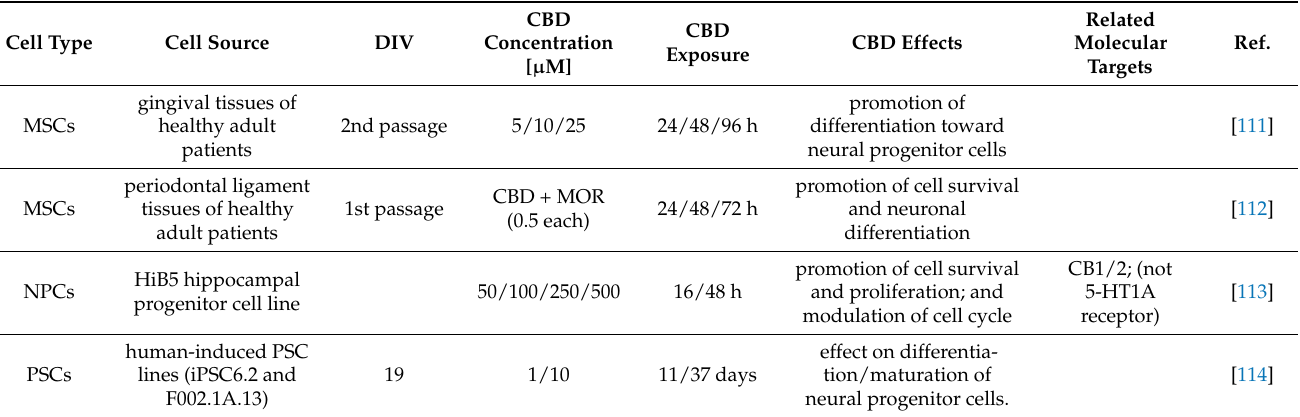
Table 3. CBD actions on stem